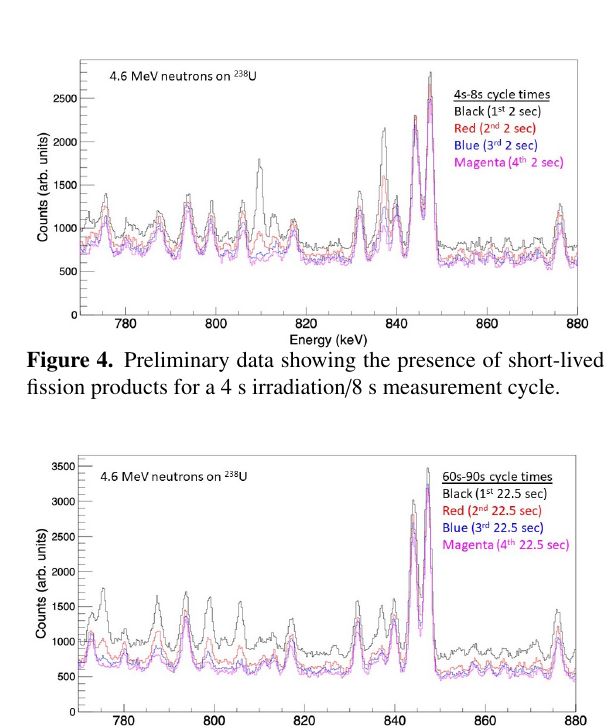
Figure 3. Au standard test of the system. Experimental details and results are discussed in the text.